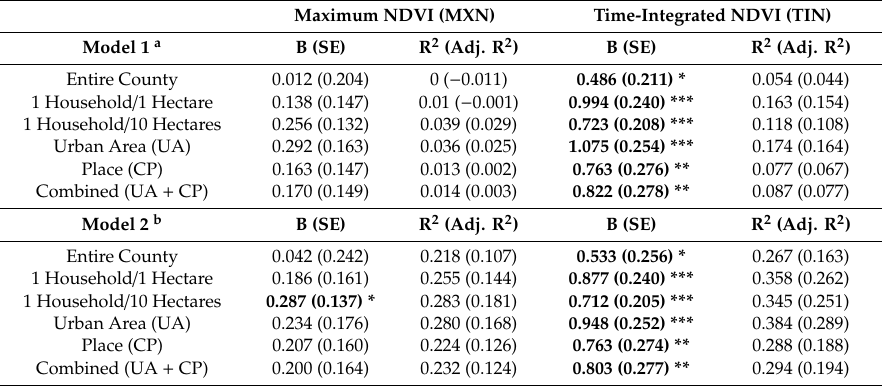
Table 2. Associations between green space and exercise using various combinations of spatial boundaries and green space measurements in Illinois.